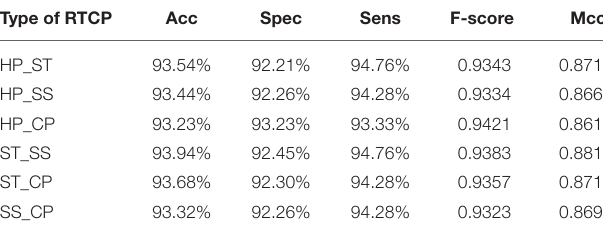
TABLE 3 | Comparison among methods based on different types of RTCP.